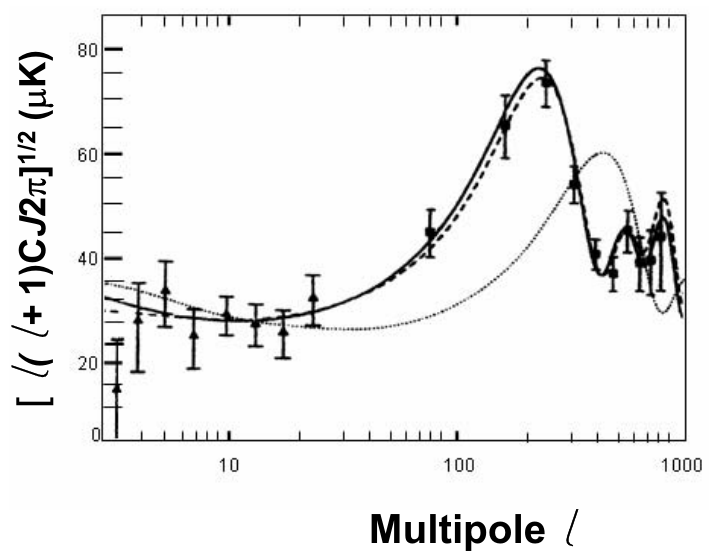
Fig. 2 – The multipole analysis of the microwave radiation background, com- bining present satellite (COBE-triangles) and balloon flight-squares) data [3,4]. The dashed curve is the best fit with a critical density. It does not depart very much from the best fit overall (solid curve). The dotted curve is expected for an open Universe with no vacuum